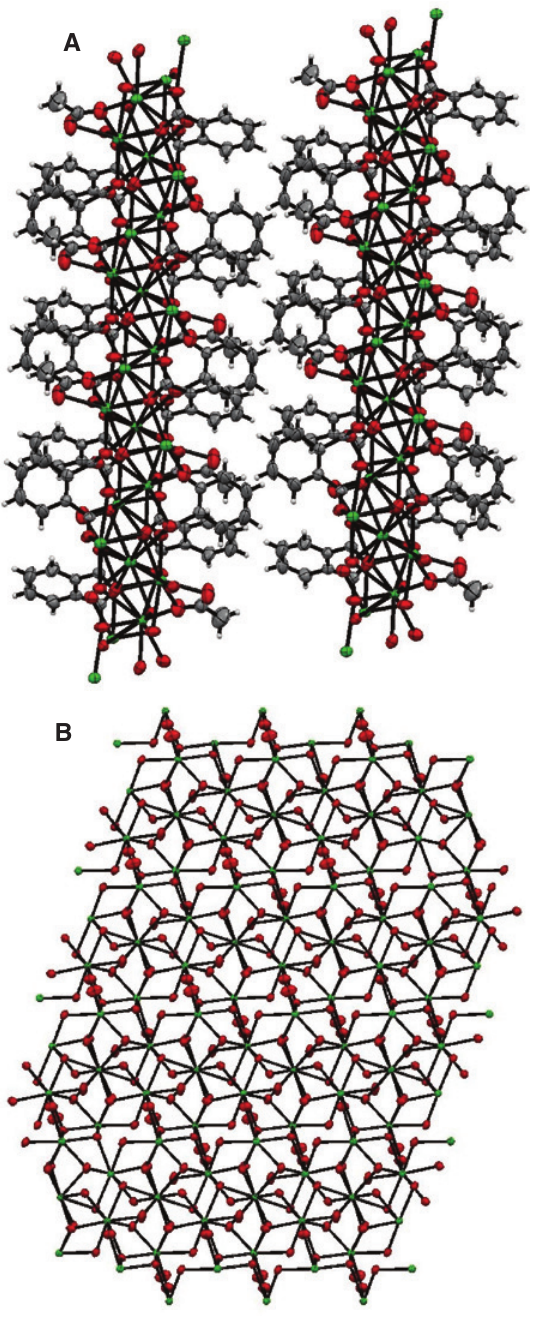
Figure 6: (A) The packing diagram of PDTP viewed along the ‘b’axis. (B) 2D inorganic layer viewed along the ‘c’ axis.